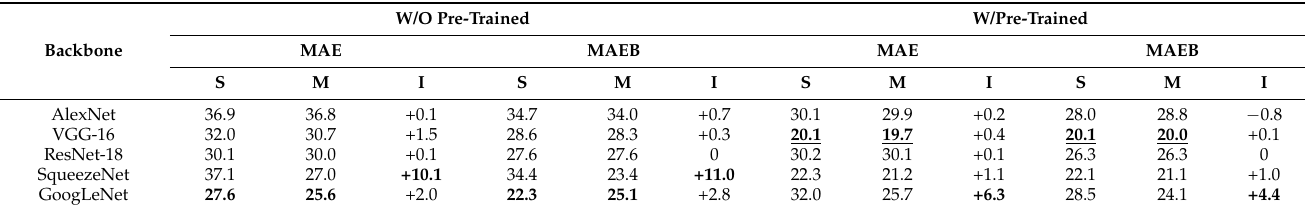
Table 4. Performance comparison on the mixed unseen test set. In the table, the baseline model is denoted as S and the proposed multitask learning model is denoted as M. The column “I” indicates the improvement achieved by applying multi-task